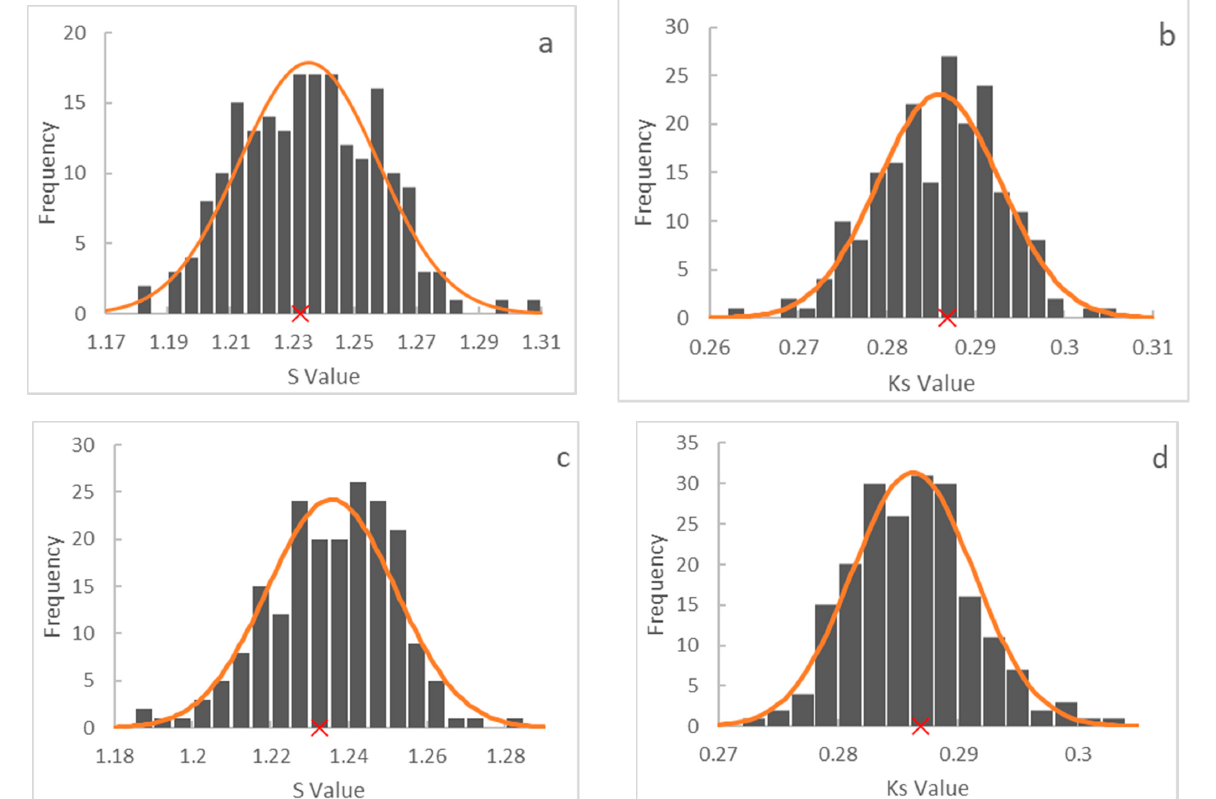
Figure 1. Frequency distribution of S ( a , c ) and K s ( b , d ) obtained using Monte Carlo ( a , b ) and Bootstrap ( c , d ) methods with 200 simulations in Sandy Soil—Grenoble using Equation (7). The red symbol (×) represents the solution given from Solver.